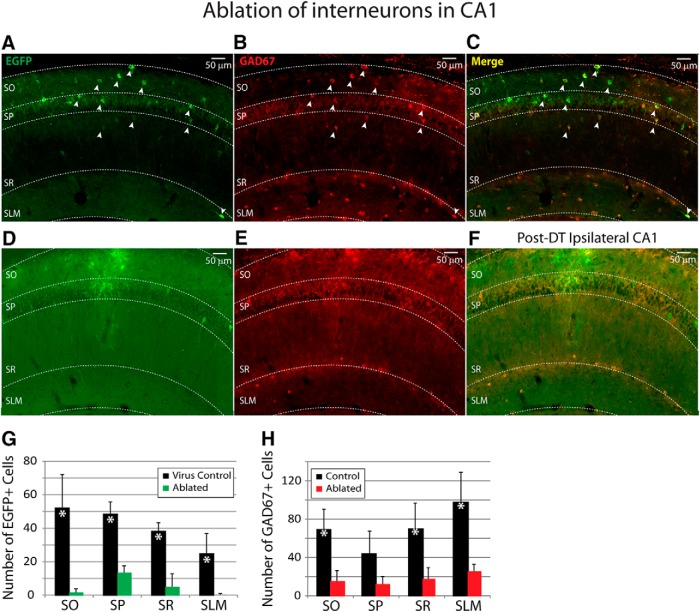
Hippocampal interneurons are lost after targeted ablation by systemic DT administration. A-C, EGFP-expressing interneurons in the CA1 region coexpress GAD67 (arrows). D-F, At 6 d after DT treatment, a significant loss of EGFP-expressing (green, D) and GAD67-expressing (red, E) cells can be seen in the merged image (F), across all subregions of CA1. G. Quantification of the average number of virus-transfected cells (n = 3 mice/group) demonstrated a large population of EGFP-expressing cells in virus-transfected control mice that had not been given DT, and a significant reduction in EGFP-expressing cells in virus-transfected mice that had been given DT. H, Quantification of GAD67-expressing cells (in the same tissue as G for virus-transfected control and virus-transfected ablated) confirmed that the ablation resulted in a significant reduction of interneurons across all regions in the ablated (n = 3) compared to the control mice (grouped for comparison, n = 6: n = 3 virus-transfected control and n = 3 toxin control). Asterisks indicate significance at p < 0.01, two-way ANOVA, control versus ablated.